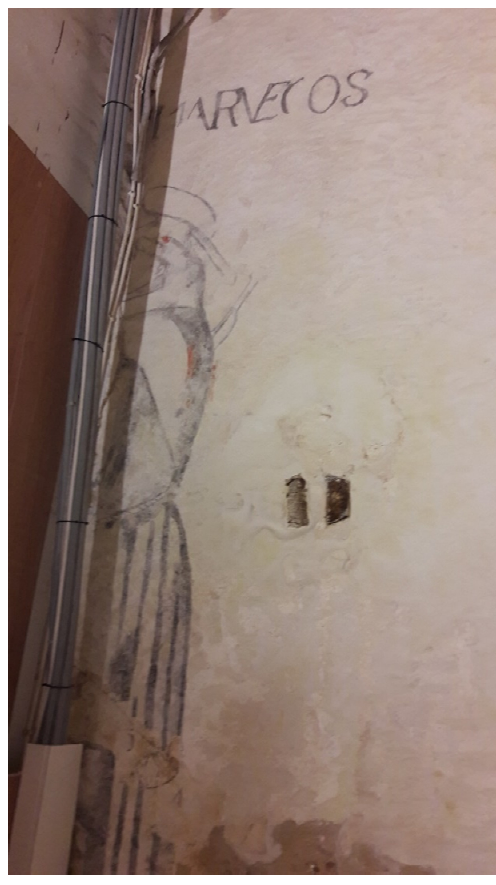
Figure 18. The Martyrs of Morocco. Fresco painted in the refectory of the Convento de San Francisco (today the Convent, Gibraltar).